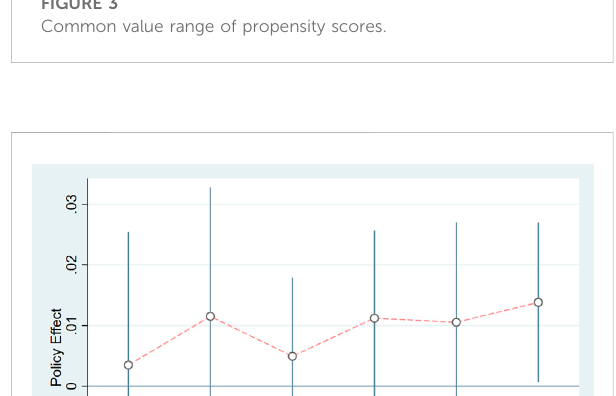
FIGURE 3 Common value range of propensity scores.